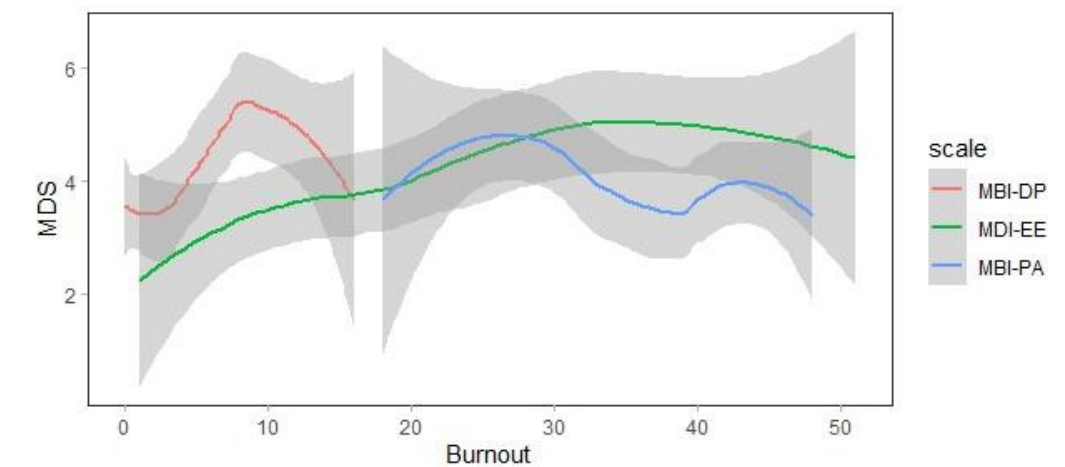
Figure 1. Correlation between MDS-R and MBI-EE, MBI-DP and MBI-PA scores.